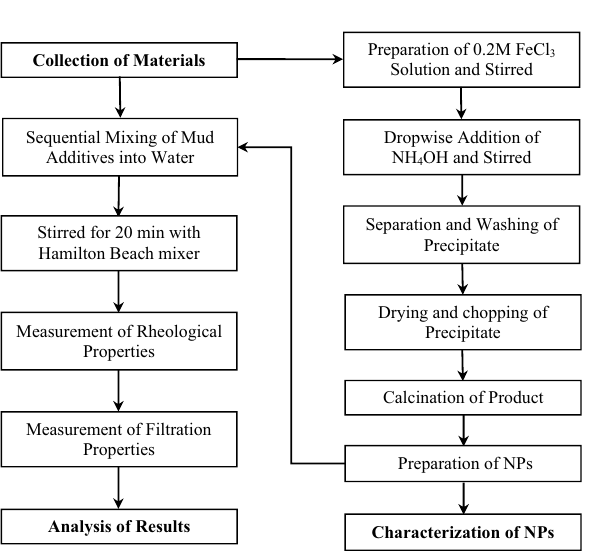
Fig. 1 Flowchart of the experimental analysis